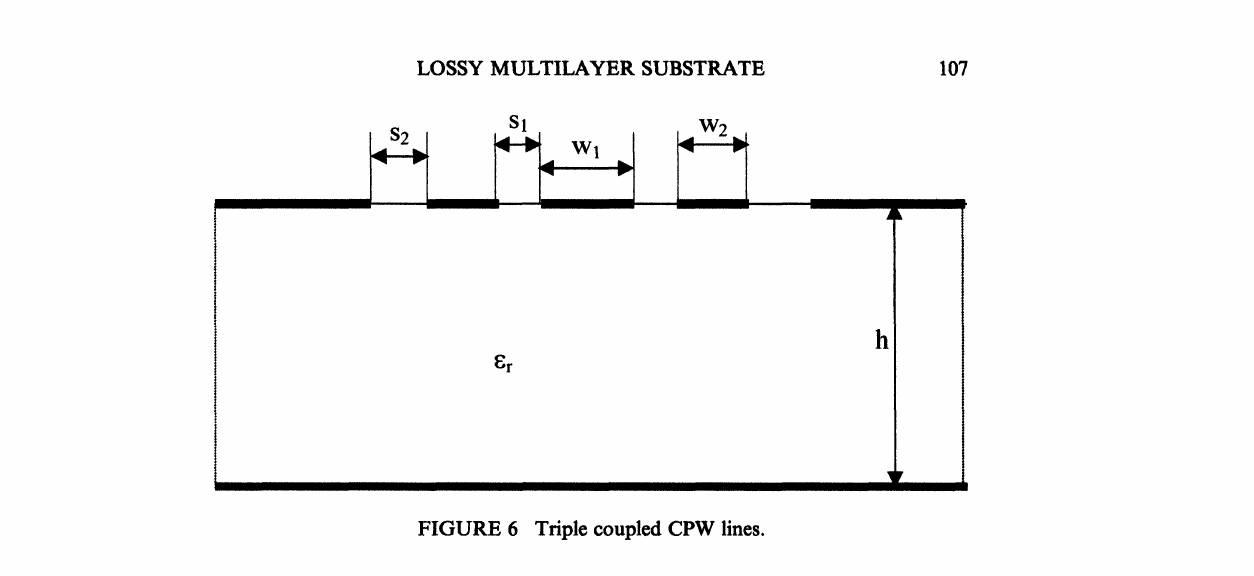
FIGURE 6 Triple coupled CPW lines.